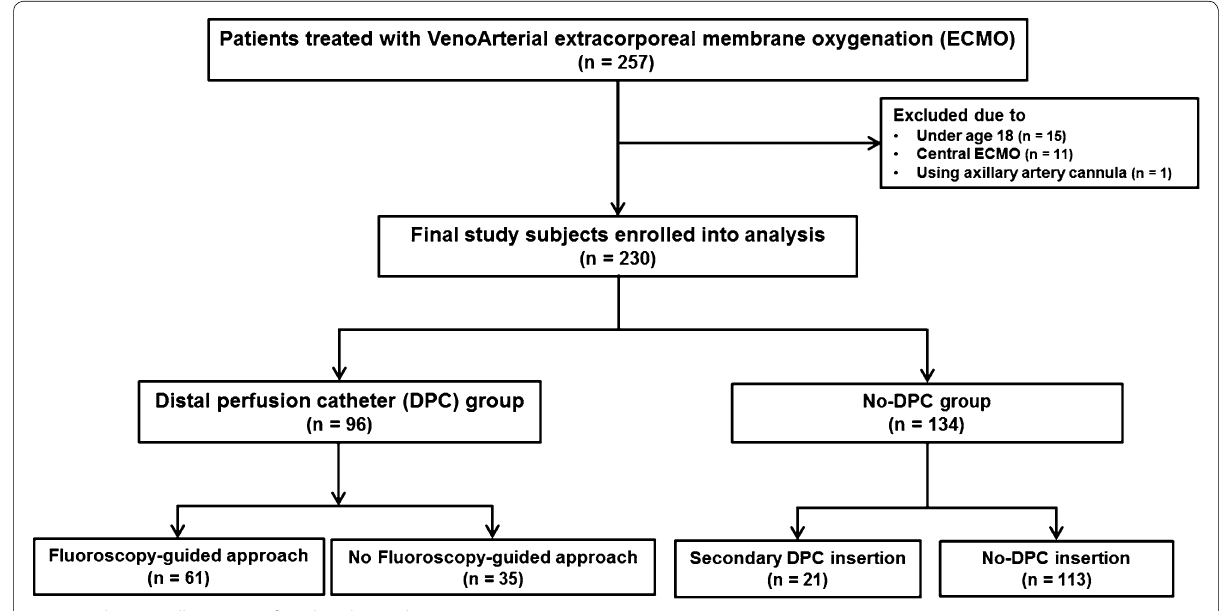
Fig. 1 Schematic illustration of study cohort